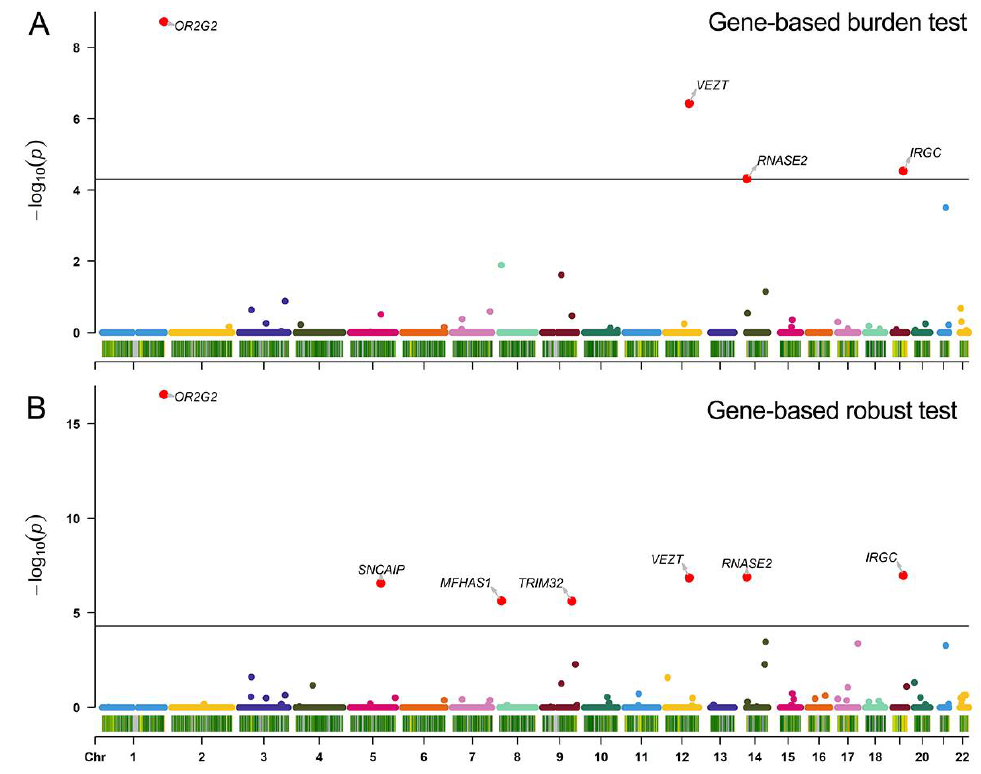
Figure 1. Manhattan plots of the exome-wide association results of rare habitual coffee consumption- related variants. ( A ) The exome-wide association results for gene-based burden tests. ( B ) The exome- wide association results for gene-based robust tests. The plots show the gene-based Bonferroni adjusted p values against their genomic position for association with habitual coffee consumption. Each dot on the x-axis represents a gene, and the association strength on the y-axis represents the − log10 (Bonferroni adjusted p value) from SKAT burden test or SKAT robust burden test aggregating rare variants (MAF < 0.01) by gene. Chr, chromosome. Table 2. Gene-based association analysis results of habitual coffee consumption.